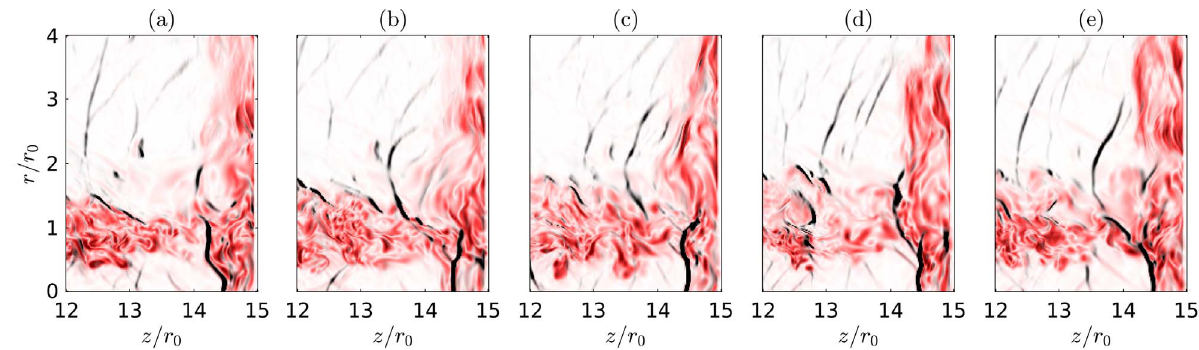
Figure 14. Fields of density gradient o q / o z (black) and vorticity (red) near the plate for L = 15 r 0 at (a) t = 0, (b) t = 2.5 r 0 / u e , (c) t = 5 r 0 / u e , (d) t = 7.5 r 0 / u e and (e) t = 10 r 0 / u e . The color scales range from 0 to 4 q 0 / r 0 for the density gradient, from white to black, and from 0 to 7.5 u e / r 0 for the vorticity, from white to red.